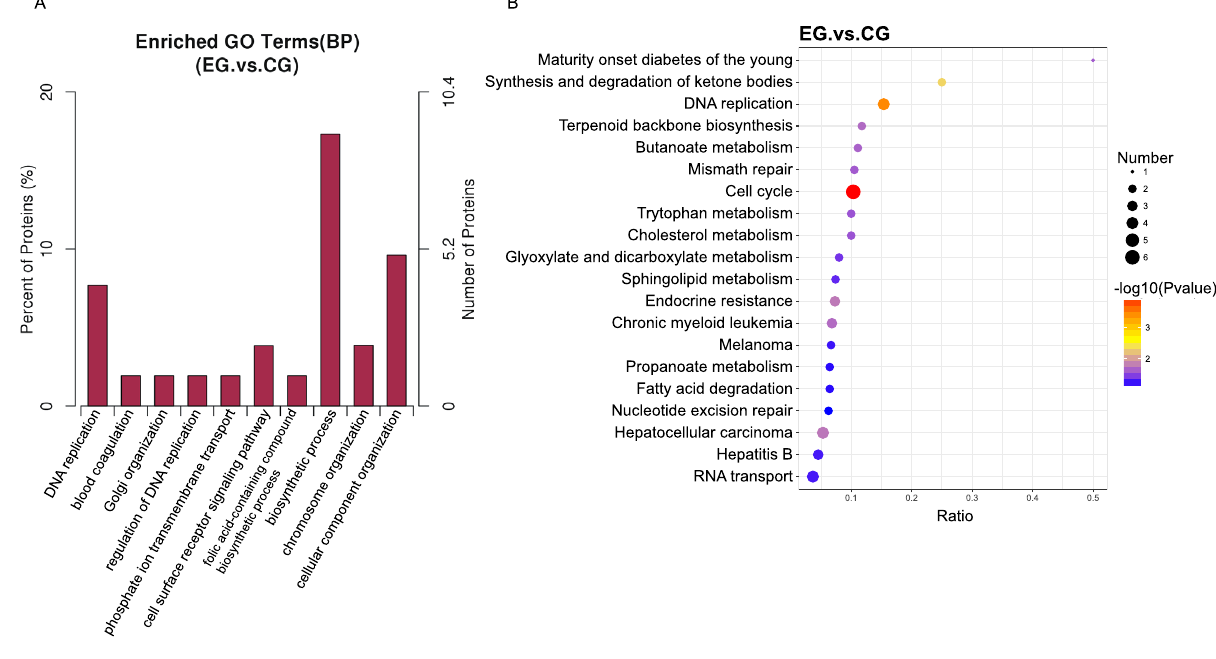
Figure 3. Differential protein enrichment analysis. ( A ) Analysis of differential protein GO enrichment of BP terms in cells cultured in basket bioreactors. ( B ) Upregulated protein bubble map by KEGG analysis of the differential proteins in cells cultured in basket bioreactor. EG samples from the basket bioreactor, CG control samples 15–17